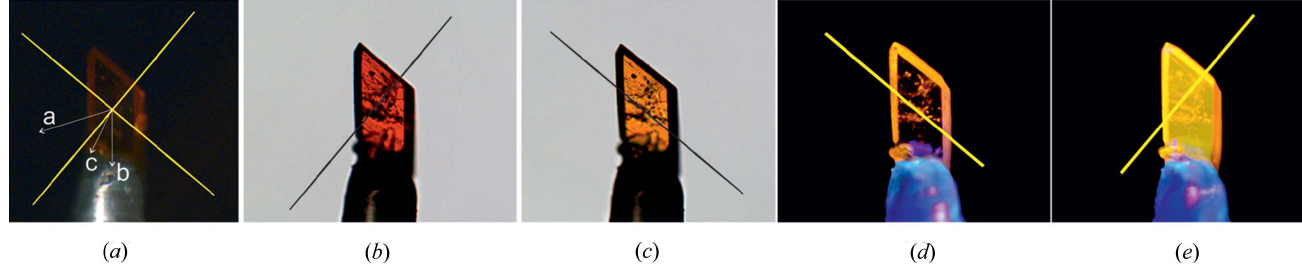
Figure 5 Microscopic images of a TAAP single crystal with the dimensions 0.28 (cid:5) 0.13 (cid:5) 0.06 mm obtained for ( a ) crossed polarizers (yellow lines indicate the polarization direction of Nicols); for two different angular orientations of the polarizer producing ( b ) the red colour ( ca [110]) and ( c ) the yellow colour ( ca [110]) of the crystal, respectively; positions for the crystal illuminated by the light of a UV-LED diode ( (cid:5) ex = 410 nm) (yellow lines indicate the analyser direction for fluorescence observation) showing ( d ) lack of emission and ( e ) maximum intensity of